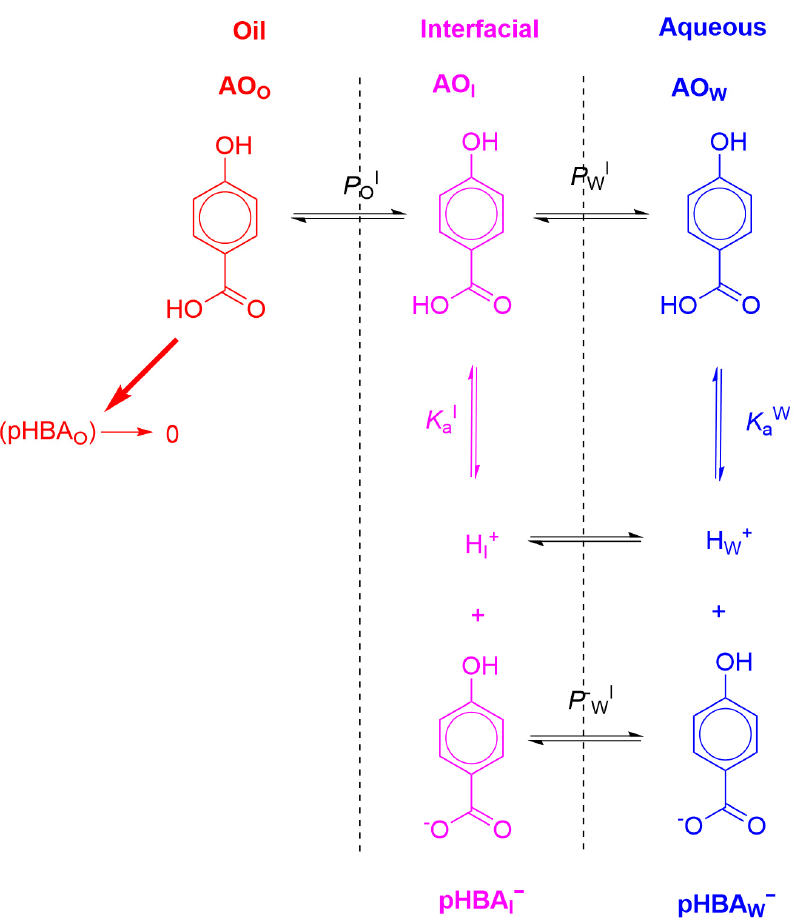
Figure 12. Equilibria for the distribution of a phenolic acid, AO, in emulsions. Phenolic acids only ionizes significantly at the typical acidities (pH = 2–6) of the emulsified foods. Adapted from Losada-Barreiro et al. [78] with permission, copyright J. Wiley and Sons.